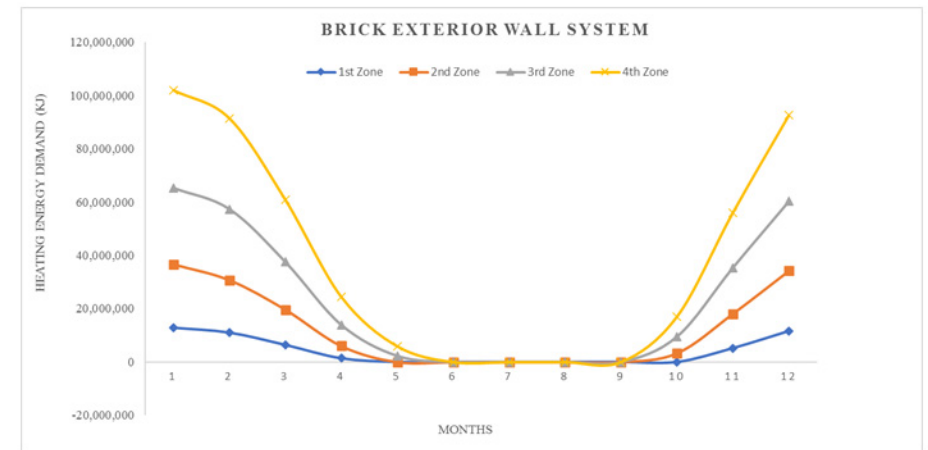
Figure 11. Heating energy demand for brick exterior wall system .